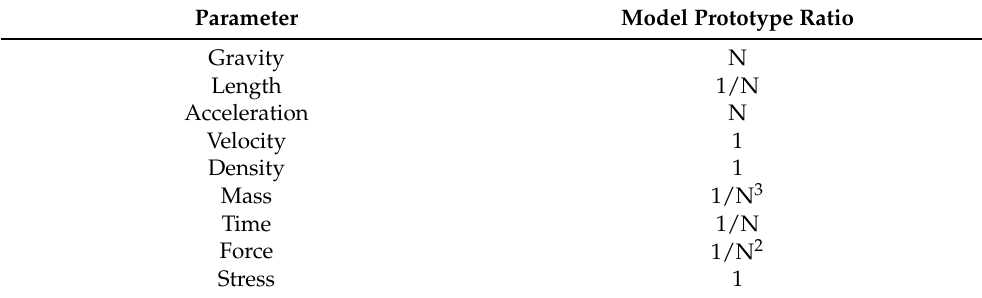
Figure 6. 2-D cross section showing generated air bubbles at different depth locations: ( a ) D = 0.6 m, ( b ) D = 2.7 m and ( c ) D = 4.8 m for 92% saturated soil deposit at the start of the simulation. The air bubble is represented by white color, solid particles are represented by the yellow color and the liquid is represented by the blue color. Table 2. Scaling laws used for the conducted simulations.